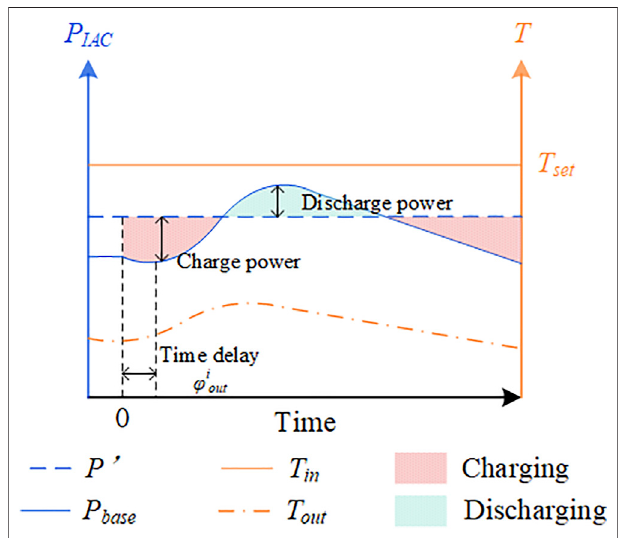
FIGURE 3 | Schematic diagram of the VCDP de fi nition.